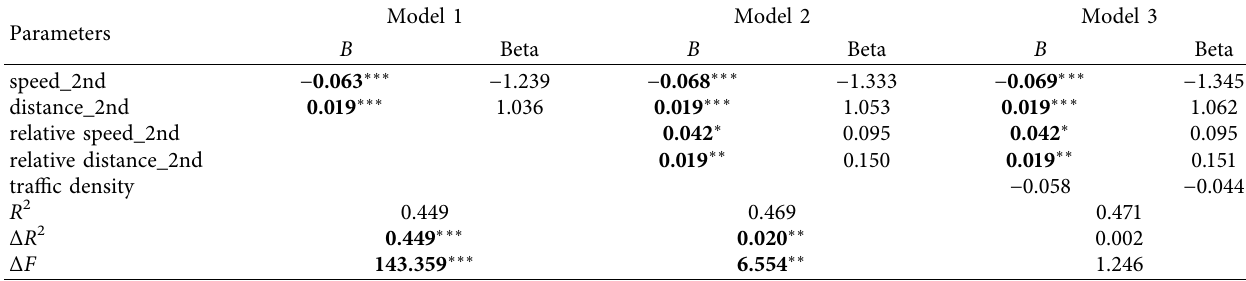
Table 9: Results of the maximum deceleration based on the following state.